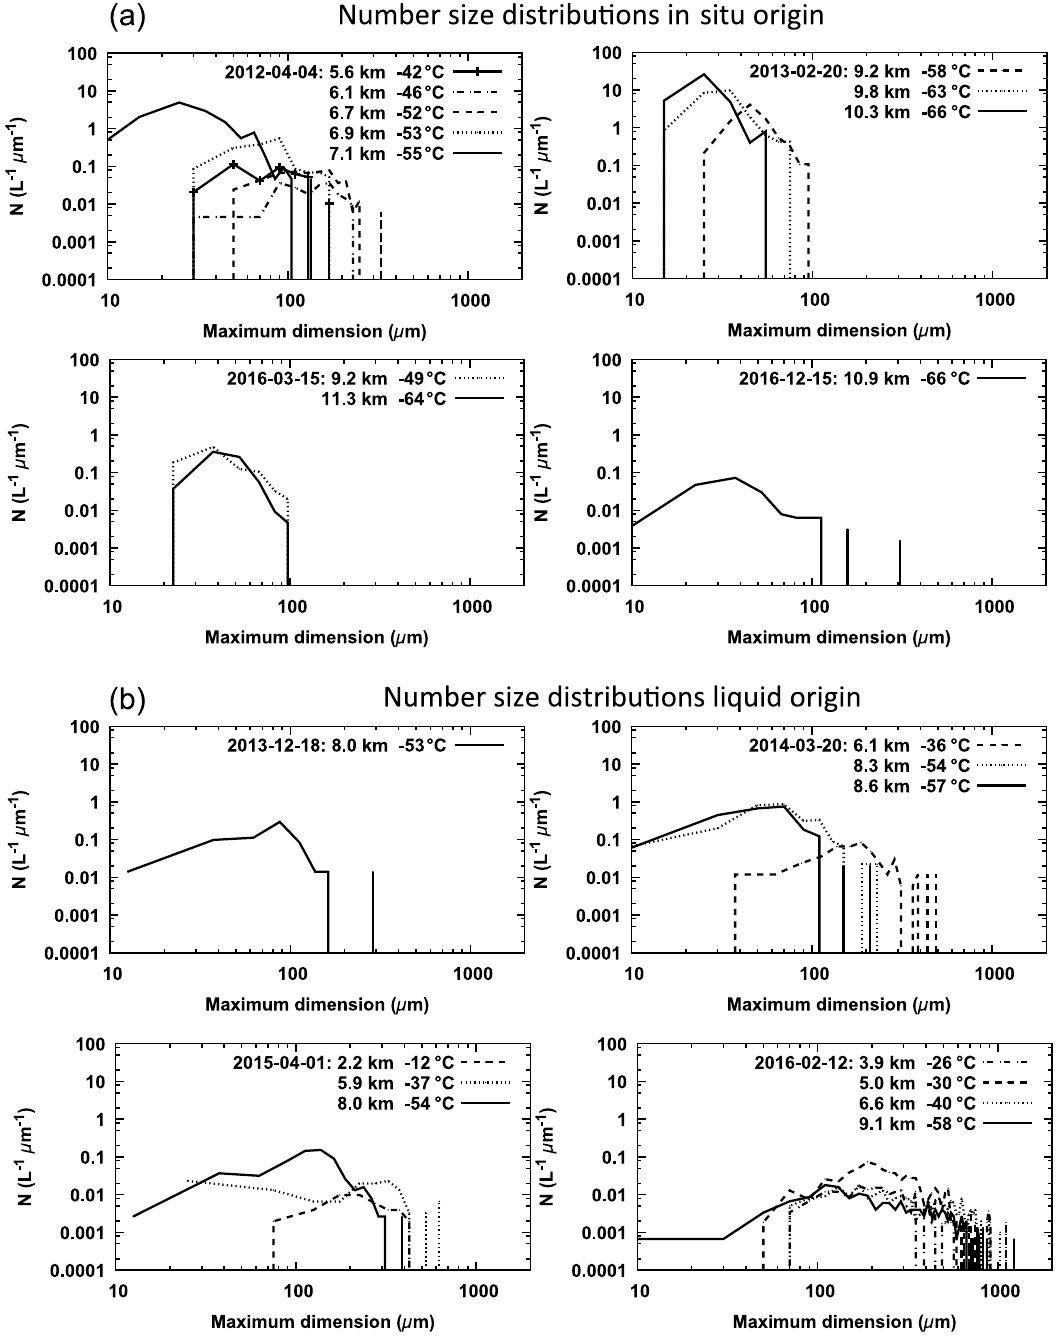
Figure 7. Number size distributions for all measurement days for different cloud levels ( a : in situ origin; b : liquid